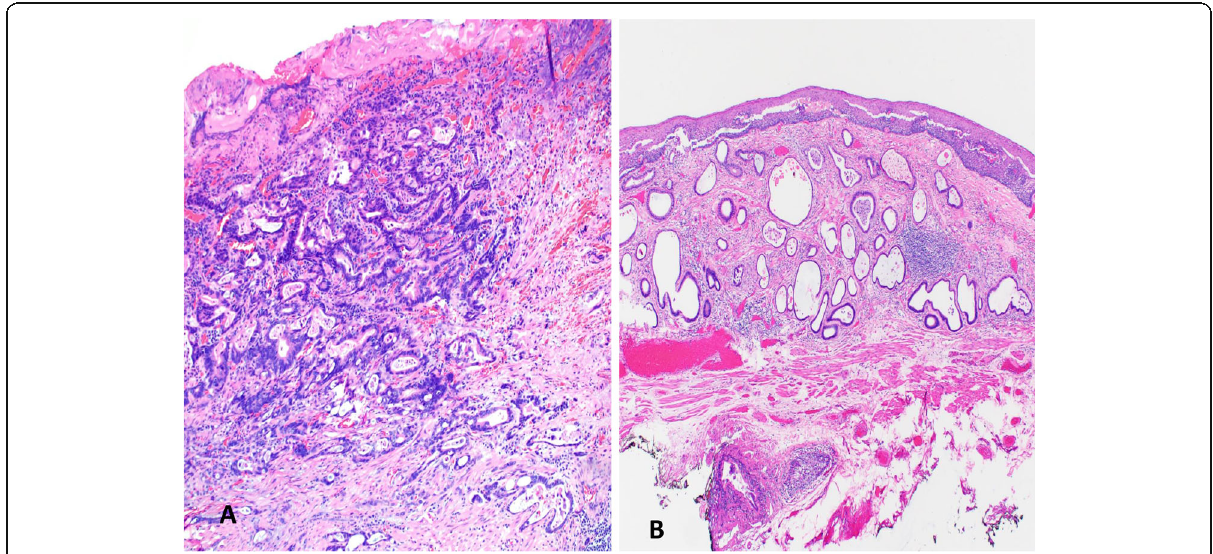
Fig. 2 A . Invasive adenocarcinoma with tubuloinfiltrative pattern. Hematoxylin and Eosin stain. × 100. B . Invasive adenocarcinoma with tubulocystic pattern. Hematoxylin and Eosin stain. ×